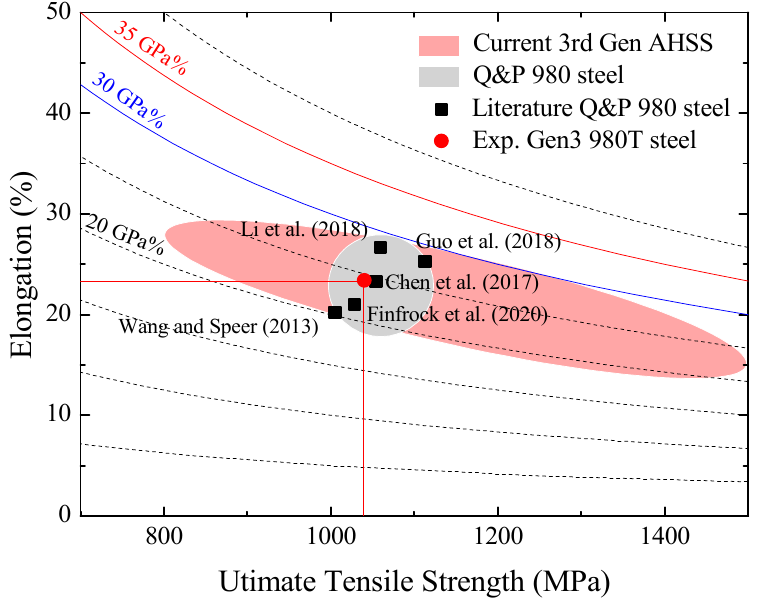
Figure 8. Placement of the investigated CR980XG3 TM steel in the global formability diagram. Data from [11,17,18,22,23].